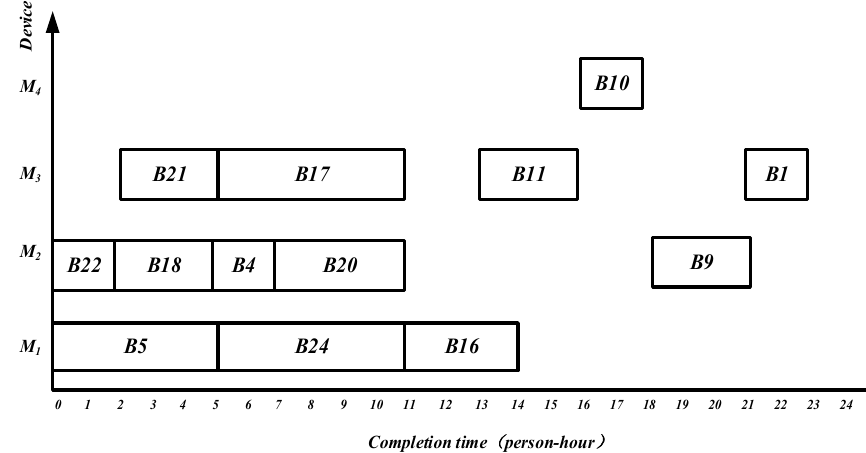
with 20 person ‐ hours. 2